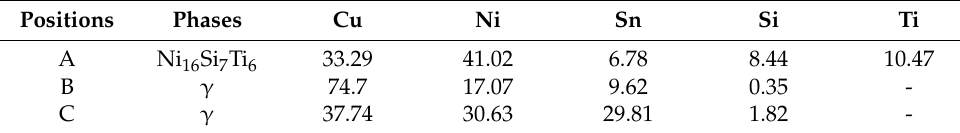
with an average size of 1.2 µ m (Figure Figure 6 indicates the microstructural features of the modified alloy after solution processing at 1093 K for 1 h. A large amount of the Ni 16 Si 7 Ti 6 and γ phases can still be observed in the alloy. Figure 6b shows micron particles are distributed around the grains, which implies the inhibiting effect of grain growth induced by these insoluble particles.